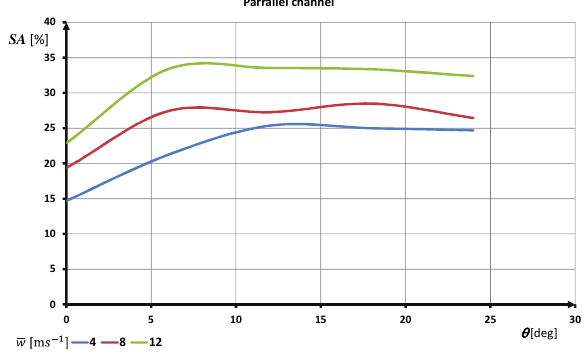
Fig. 14. The characteristic of swirl area (SA) dependence of the twisting angle ( θ ) and initial air flow velocity (w) – parallel channel The effect of the air flow velocity and the tape-twisting angle on the swirl area was observed. When the initial air flow velocity increases, the swirl area increases. The nu- merical analysis result shows that the tape-twisting angle significantly affects the SA, and these two quantities are directly proportional to each other. The results in Fig. 14 show that – when the initial air flow velocity was w = 4 m/s Fig. 12. The distribution of swirl inside the cylinder for charge’s flow – the SA was maximal for the angle θ » 12 deg. When the velocity w = 8 m/s; a) q = 6 deg, b) q = 12 deg, c) q = 18 deg, initial air flow velocity was w = 12 m/s, the maximal d) q = 24 deg